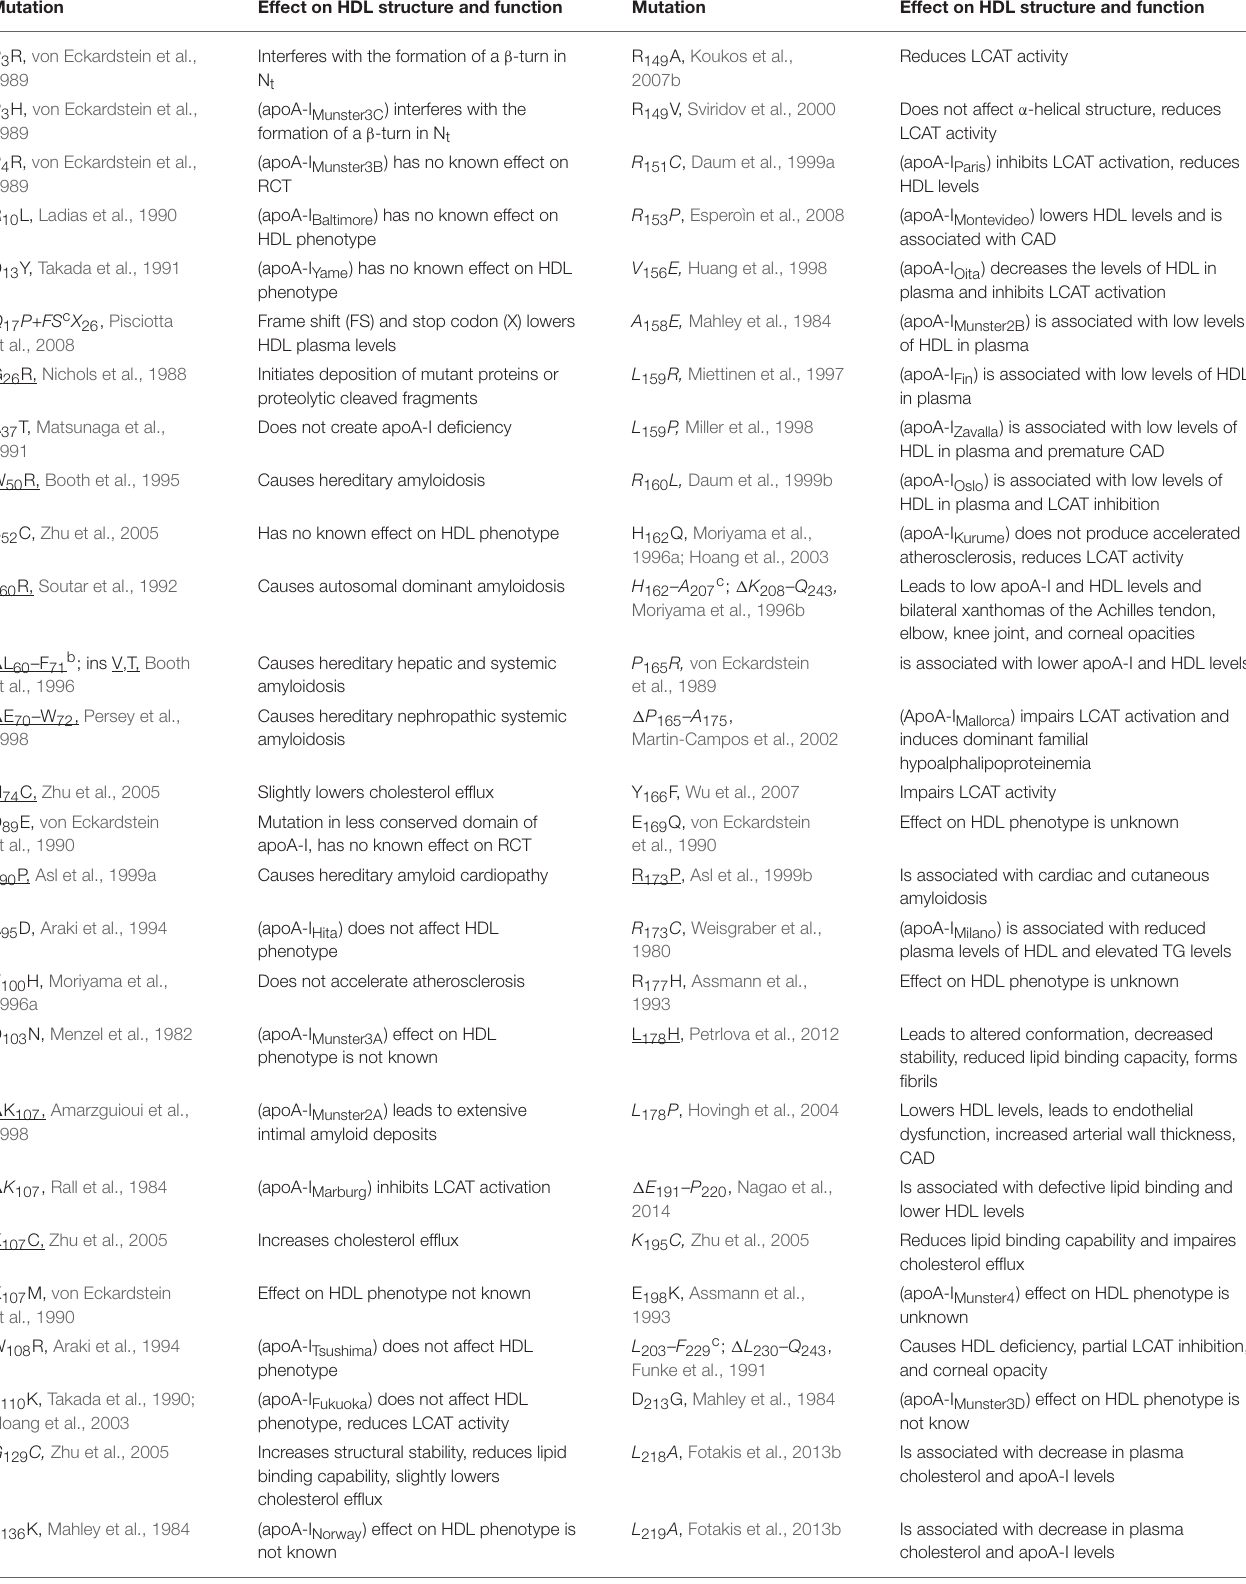
TABLE 2 | Compilation of naturally occurring and bioengineered mutations in human apoA-I a